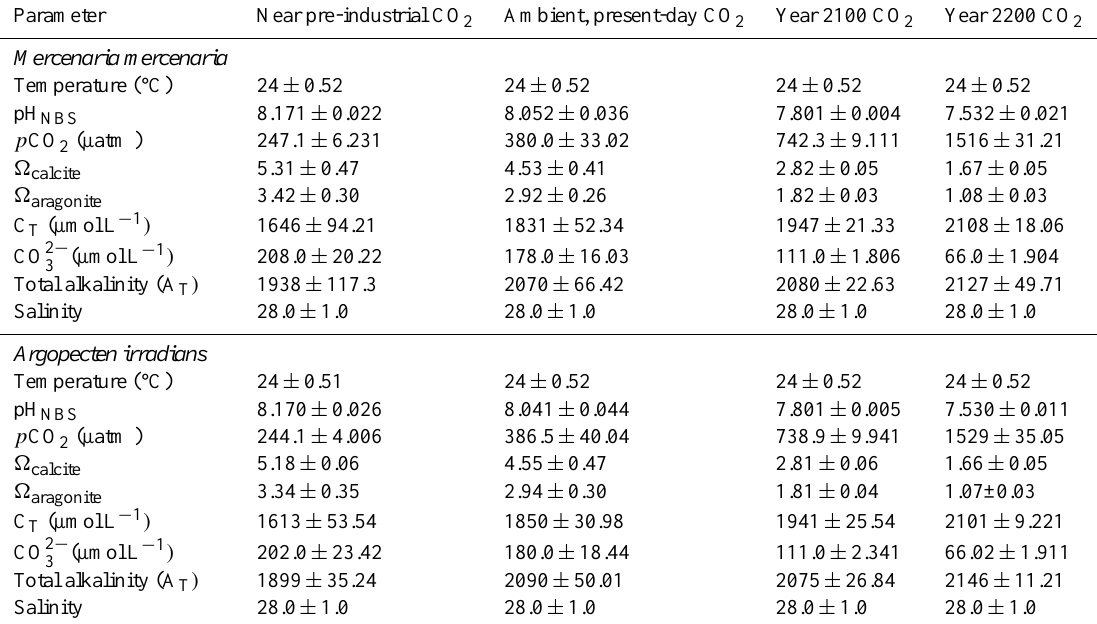
Table 3. Temperature, pH NBS , carbonate chemistry, total alkalinity, and salinity (±1SD) during the four-level carbon dioxide experiments with Mercenaria mercenaria and Argopecten irradians